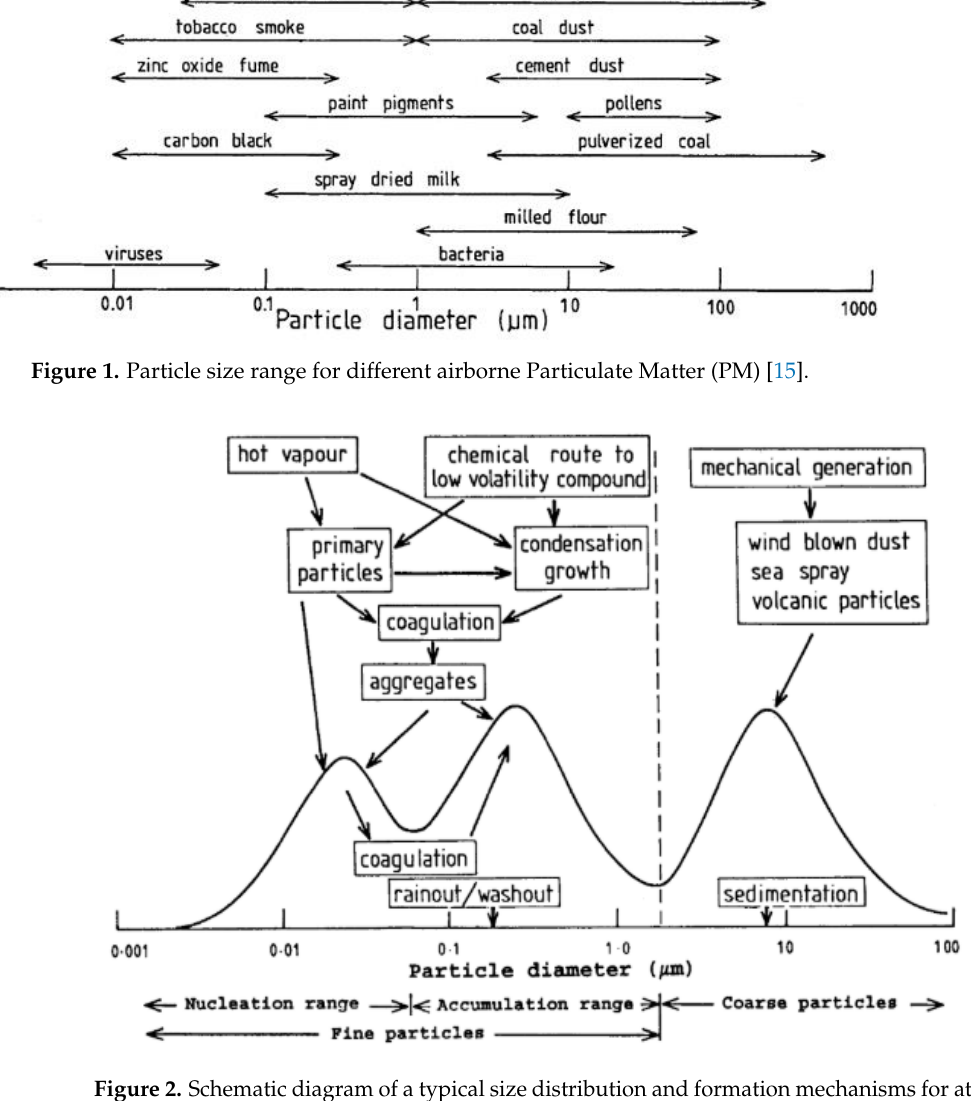
Figure 1. Particle size range for different airborne Particulate Matter (PM) [15].